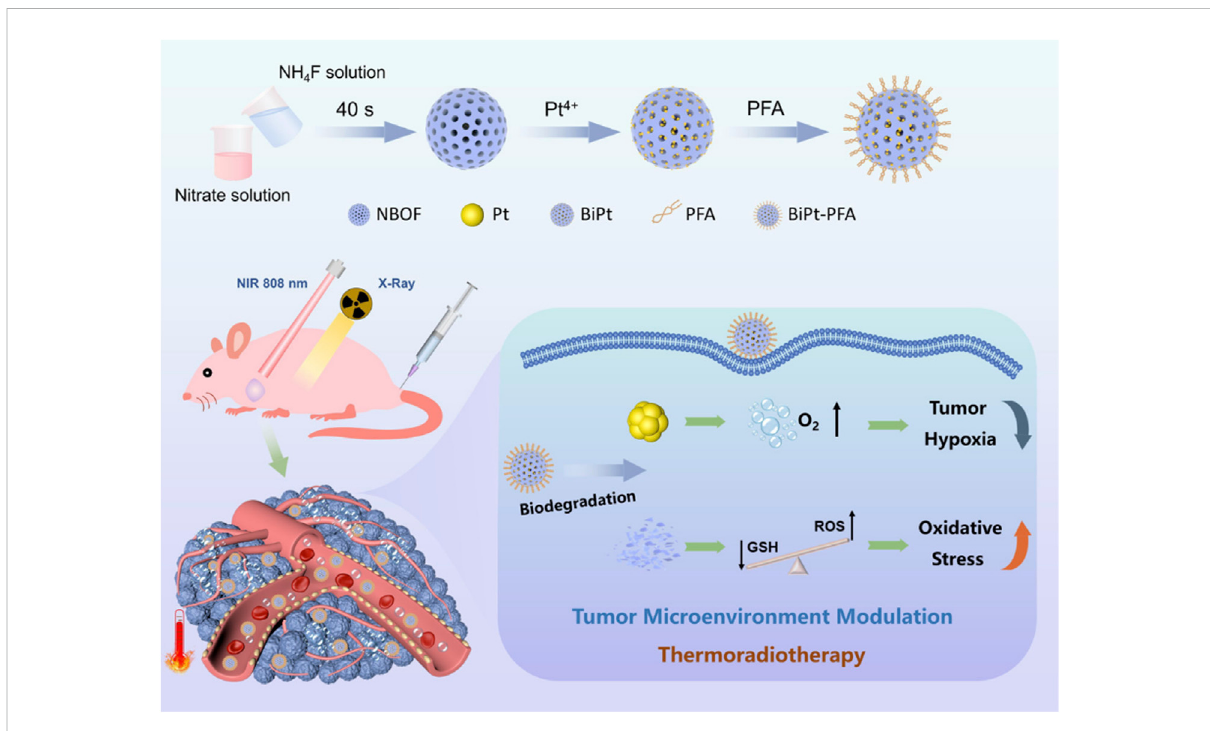
FIGURE 2 Schematic illustration of the synthesis of BiPt-PFA NPs and their application for synergistic thermoradiotherapy with hypoxic tumor (Zhang et al., 2020). Copyright © 2020 American chemical